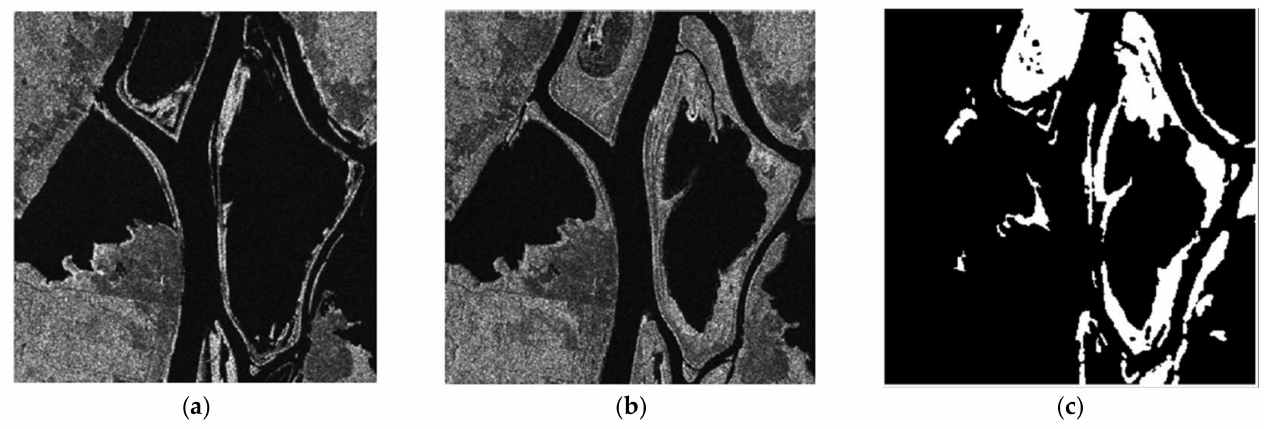
Figure 5. Multi-temporal SAR images of Ottawa. ( a ) SAR image acquired in July 1997 during the flooding. ( b ) SAR image acquired in August 1997 after flooding. ( c ) The reference map, called ground truth.